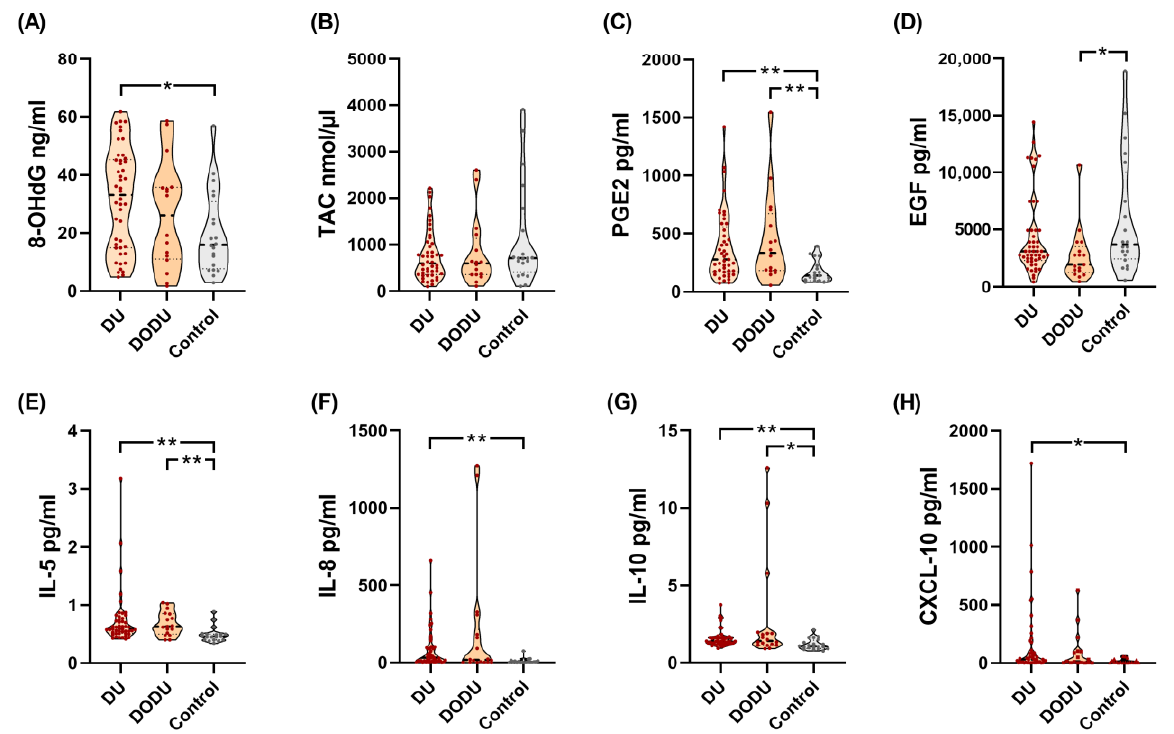
Figure 1. Violin plots of significant analytes discriminating DU, DO-DU patients, and controls. DU, detrusor underactivity. ( A ) Urine 8-OHdG levels, ( B ) Urine TAC levels, ( C ) Uriine PGE2 levels, ( D ) Urine EGF levels, ( E ) Urine IL-5 levels, ( F ) Urine IL-8 levels, ( G ) Urine IL-10 levels, ( H ) Urine CXCL10 levels; DO-DU, detrusor overactivity and detrusor underactivity; 8-OHdG, 8-hydroxy-2- deoxyguanosine; TAC, total antioxidant capacity; PGE2, prostaglandin E2; EGF, epidermal growth factor; CXCL10, chemokine (C-X-C motif) ligand 10. * p < 0.05, ** p < 0.01. By adjusting for age and sex, multivariate logistic-regression models were used to reveal the odds ratio (OR) of targeted analytes (Table 3). Urine biomarkers that signifi- cantly distinguished DU patients from controls included PGE 2 (OR = 2.165), 8-OHdG (OR = 1.557), IL-5 (OR = 1.544), IL-10 (OR = 1.318), IL-8 (OR = 1.291), TAC (OR = 0.904), and Units * EGF (OR = 0.826) (all p values < 0.05). DU vs. control PGE 2 0.026 Table 3. Multivariate models (controlling for age and sex) reveal the diagnostic values of targeted urine biomarkers in DU. Odds Ratio p Value Odds Ratio 95% CI